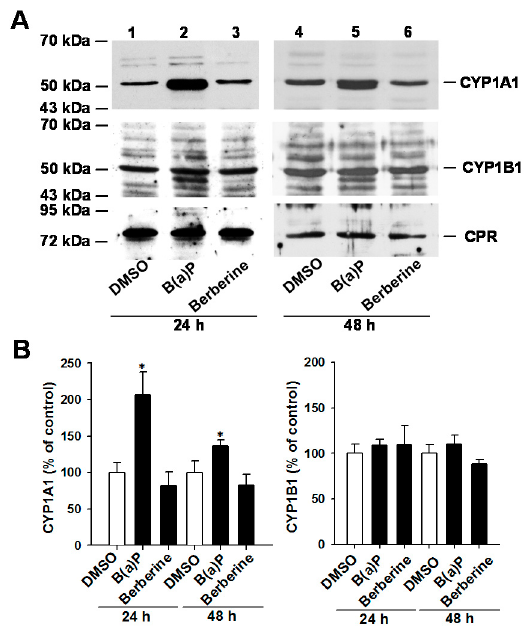
Figure 3. Immunoblot analyses of CYP1A1, CYP1B1 and CPR in the control, B(a)P (2 μ M)- and berberine (10 μ M)-treated MCF-7 cells. The vehicle control cells were exposed to the same amount of